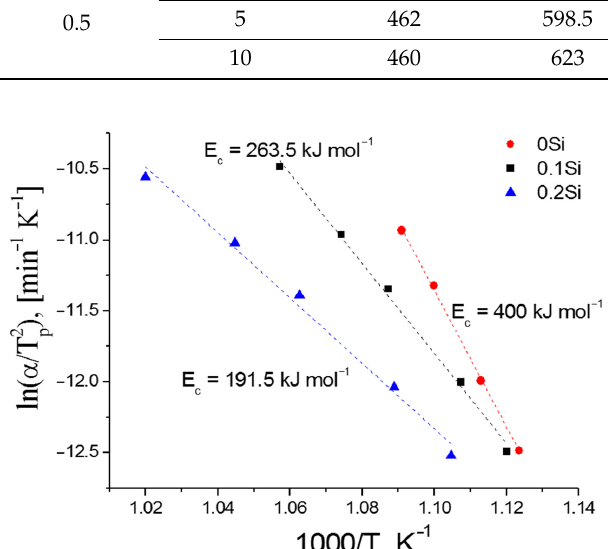
Figure 5. Kissinger plots of ln(cid:3436) (cid:3080)